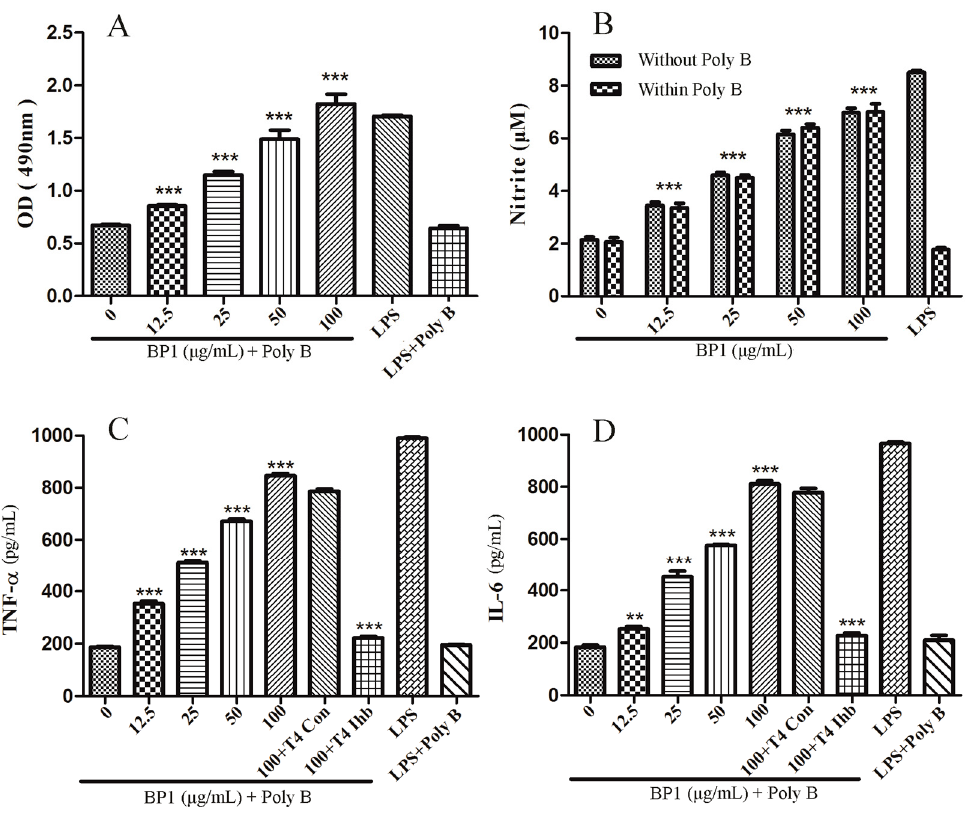
Figure 7. Immunomodulating effects of BP1. ( A ) Dose-dependent induction of the proliferation of RAW 264.7 cells; ( B ) dose-dependent effect on the production of NO by RAW 264.7 cells in vitro ; ( C ) induction of RAW 264.7 cell TNF- α secretion in vitro , and the role of TLR4 in this bioactivity; ( D ) Induction of RAW 264.7 cell IL-6 secretion in vitro , and the role of TLR4 in this bioactivity. LPS (2 µg/mL) and LPS + polymyxin B (PolyB) served as the positive control and endotoxin-excluded control, respectively. Each value is expressed as the mean ± SD ( n = 3). Level of significance: ** p < 0.01; *** p < 0.001 compared to untreated cells (at 0 µg/mL).